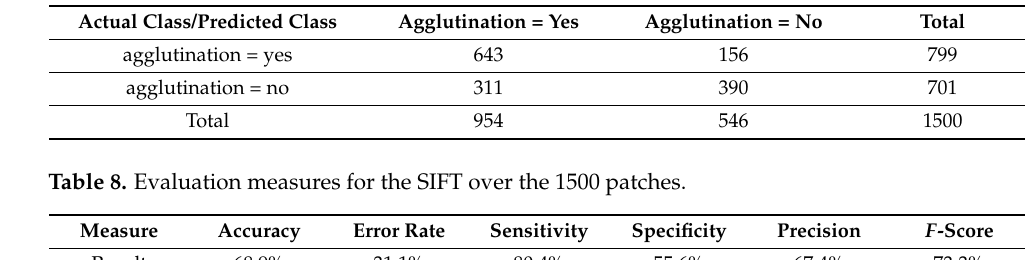
Table 7. Confusion matrix for the SIFT over the 1500 patches.